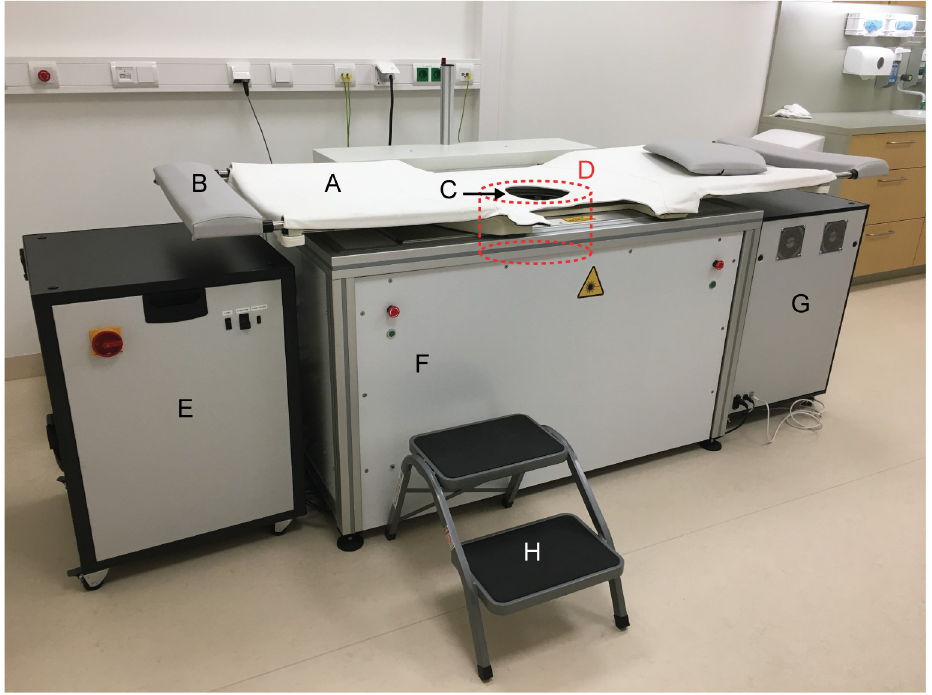
Fig 1. PAM 2 system in hospital setting with (A) the bed on which a woman lies prone, (B) a foot rest, and (C) the breast aperture with (D) a schematic of the shape and position of the imaging tank below the bed, (E) the power supply and cooling unit, (F) laser head (behind the panel), (G) DAQ unit, and (h) step stool. Reproduced from Ref. [11] with permission of authors and publisher.